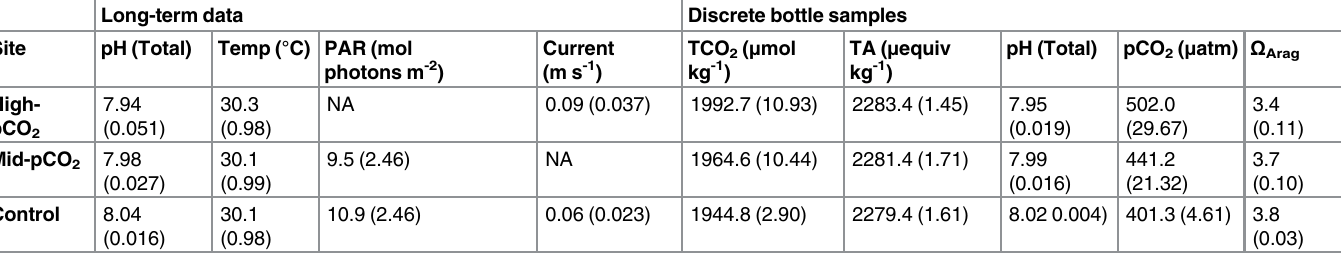
Table 1. Environmental data from the Maug study sites. Data and methods can be found within Enochs et al . [38]. Long-term data taken from multi- month deployment of data loggers over the duration of the experiment. Discrete bottle samples (n = 8) taken every 6 hours over a two-day period. Numbers in parentheses are standard deviation for long-term data and standard error of the mean for discrete bottle